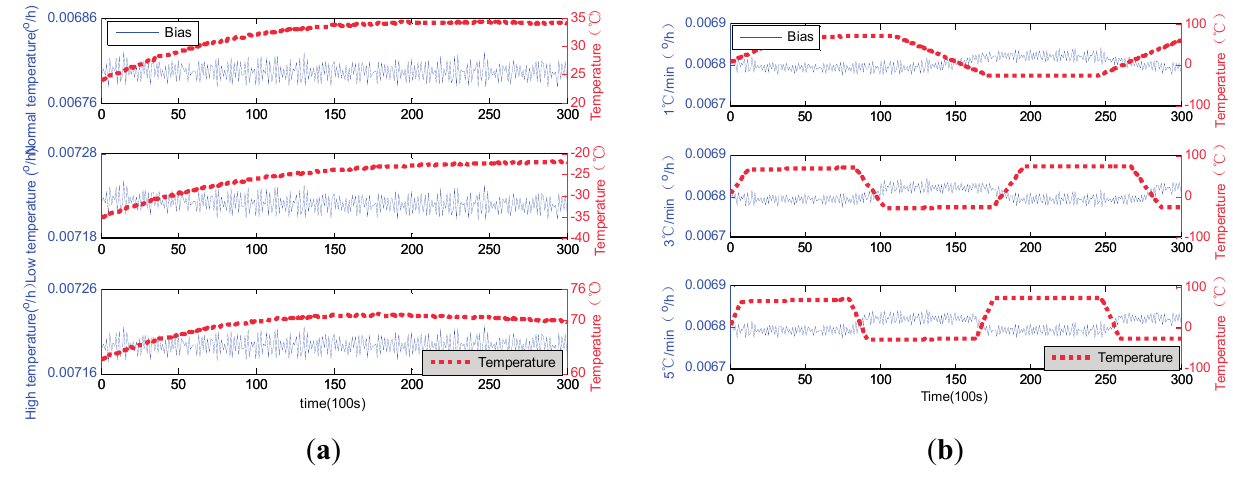
Figure 5. Filtered zero bias and for the laser gyro: ( a ) constant temperature; ( b ) variable